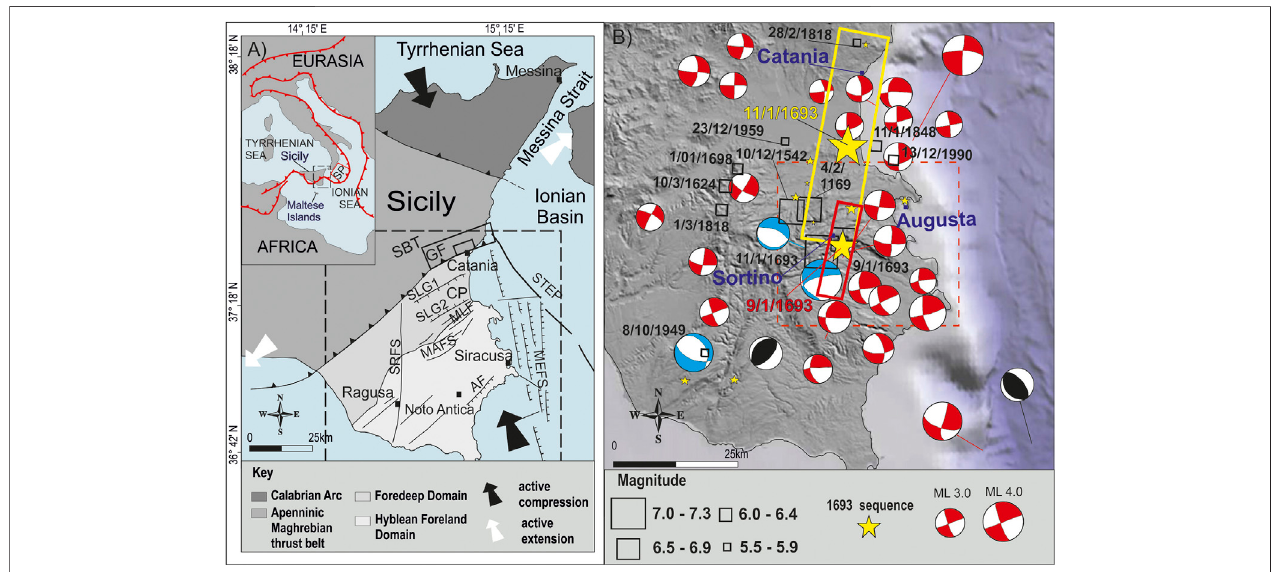
FIGURE1|(A) EasternSicily: principalgeodynamic sectors,mainstressaxes (from Musumeciet al.,2014),and themainregionalfaultsproposedasseismogenic faultofthe1693earthquakes (DISS Working Group, 2018).SP (cid:1) Subduction Plane (Gutscher et al., 2006),see the insetof (A) ; MEFS (cid:1) Malta EscarpmentFault System (Piatanesi and Tinti, 1998; Azzaro and Barbano, 2000; Jacques et al., 2001; Argnani and Bonazzi, 2005); SRFS (cid:1) Scicli-Ragusa Fault System (Sirovich and Pettenati, 2001; DISS Working Group, 2018); AF (cid:1) Avola Fault (Bianca et al., 1999); SLGF1 and SLGF2 (cid:1) Scordia-Lentini Graben Faults (D ’ Addezio and Valensise, 1991); GF (cid:1) Gravina Fault (DISS Working Group, 2018); MLF (cid:1) Monte Lauro Fault (DISS Working Group, 2018), which corresponds to MAFS (cid:1) Monterosso-Agnone Fault System;SBT (cid:1) SicilianBasalThrust(Lavecchiaetal.,2007;DISSWorkingGroup,2018);STEP (cid:1) SlabTransferEdgePropagatorfaultsystem(Poloniaetal.,2012);CPis theCataniaPlain.Dashedsquareshowslocationof (B) . (B) SoutheasternSicilyDEM;blacksquaresaretheepicentresofthestrongesthistoricalearthquakes(from1169 to2015,afterRovidaetal.,2019);focalmechanisms(balloons)forearthquakeswithM L (cid:1) 3.0M L (cid:1) 4.0occurredfrom1999to2011(afterScarfìetal.,2013).Focalplane solution classi fi cation: red, strike-lateral fault; blue, normal fault; black, reverse fault. Yellow stars are the re-localized epicentres of the 1693 seismic sequence shocks; redandyellowrectanglesarethenewsourcesobtainedbythisworkusingtheboxermethod(Gasperinietal.,1999)employingthedataof Figure4 (seechapter3).Red dashed square is the location of Figure 2